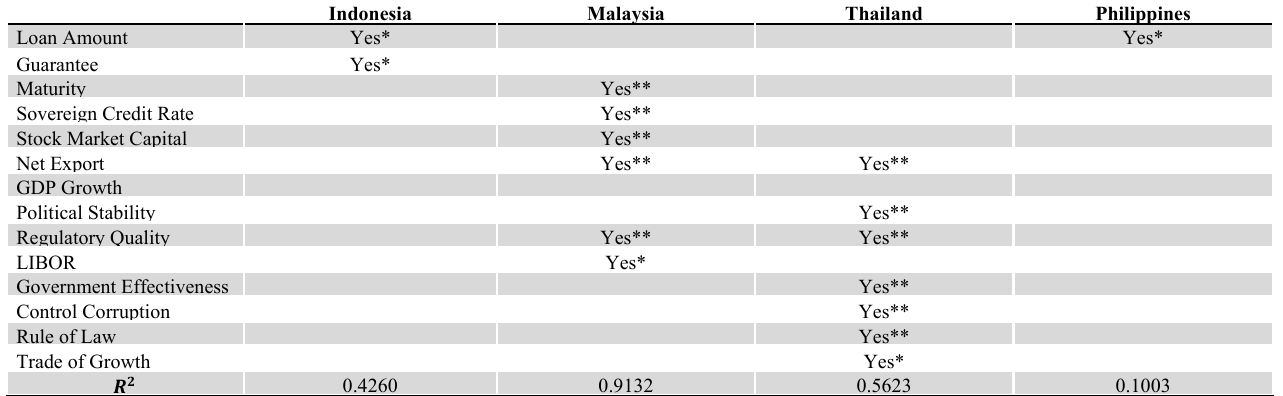
OLS Regression Results